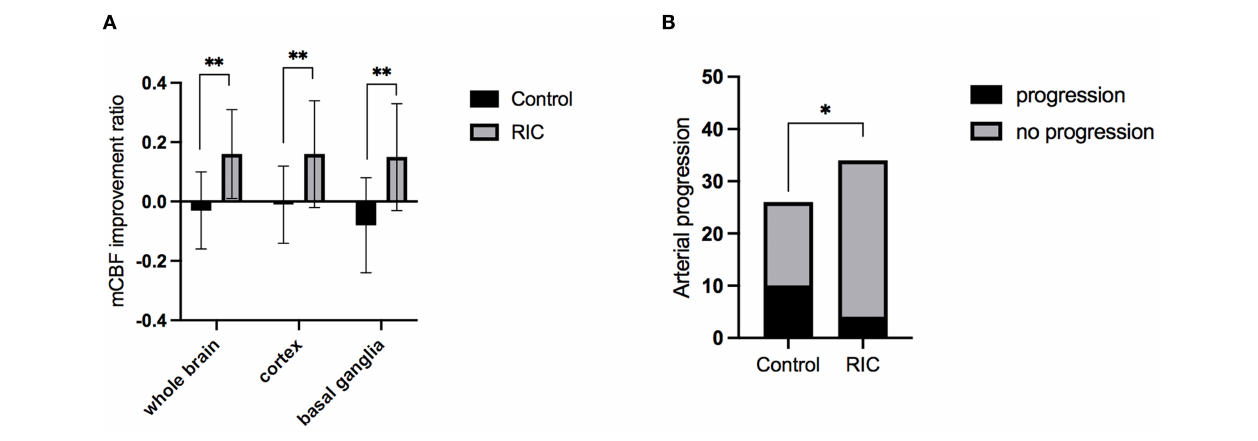
FIGURE 2 | The mCBF improvement ratio and stenotic-occlusive progression of two groups. (A) mCBF improvement ratio of whole brain, cortex, and basal ganglia between the two groups at 1-year treatment; (B) the number of hemispheres with arterial progression in two groups at 1-year follow-up; mCBF, mean cerebral blood flow; * p < 0.05; ** p <